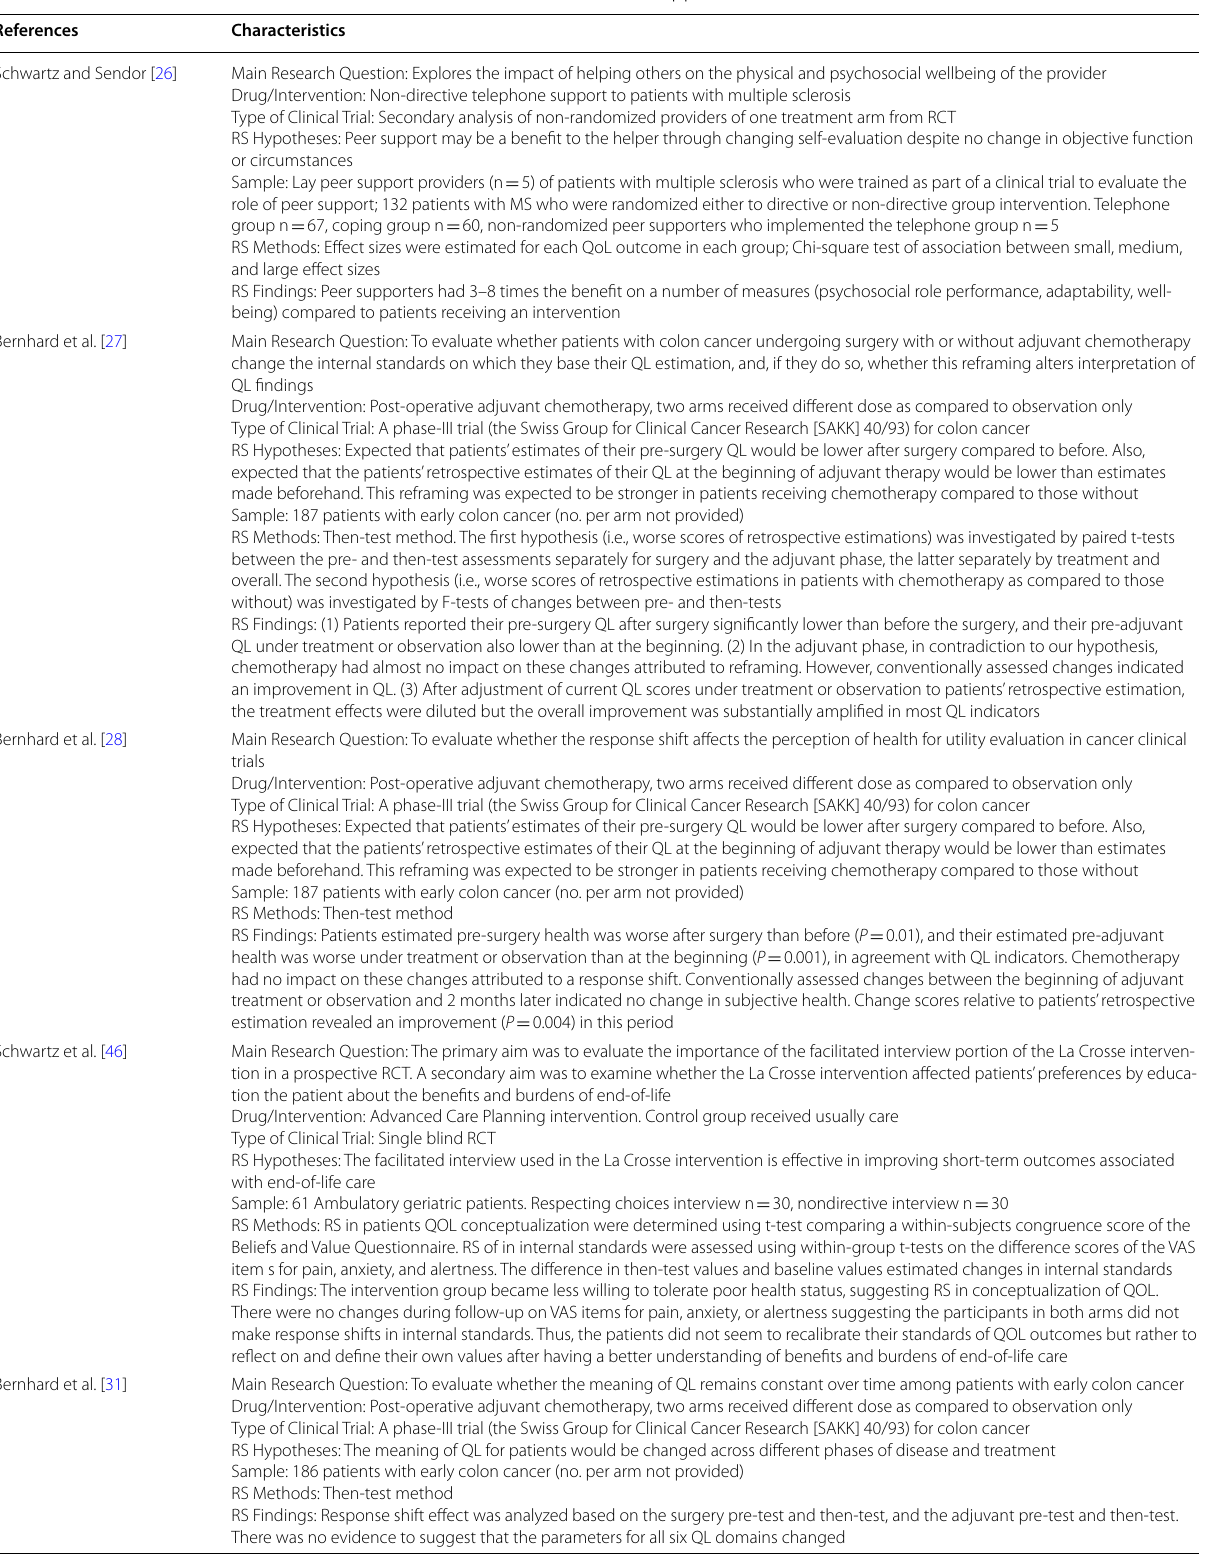
Table 2 Clinical trials articles found after initial inclusion/exclusion criteria